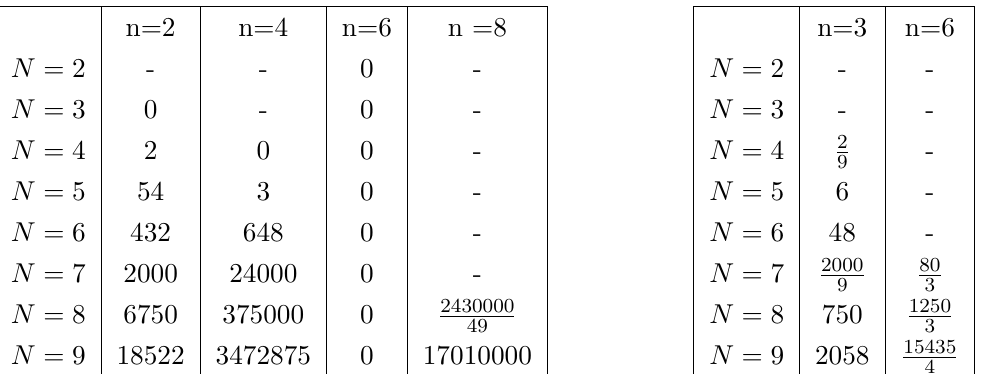
Table 4 . Evaluation of hO